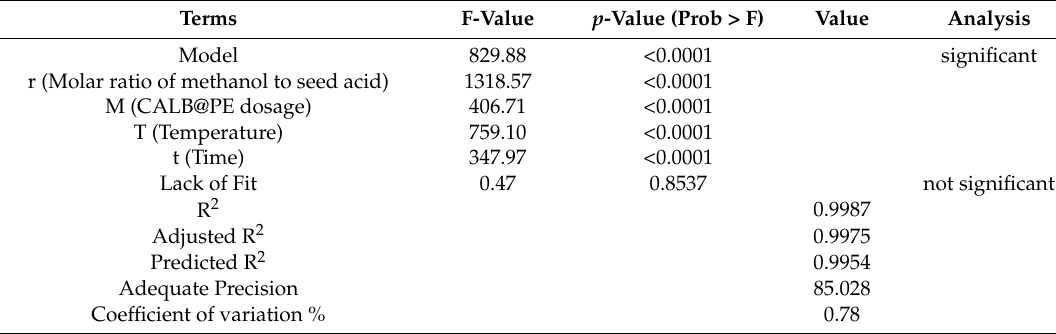
Table 3. ANOVA for the response surface quadratic model for the yield of